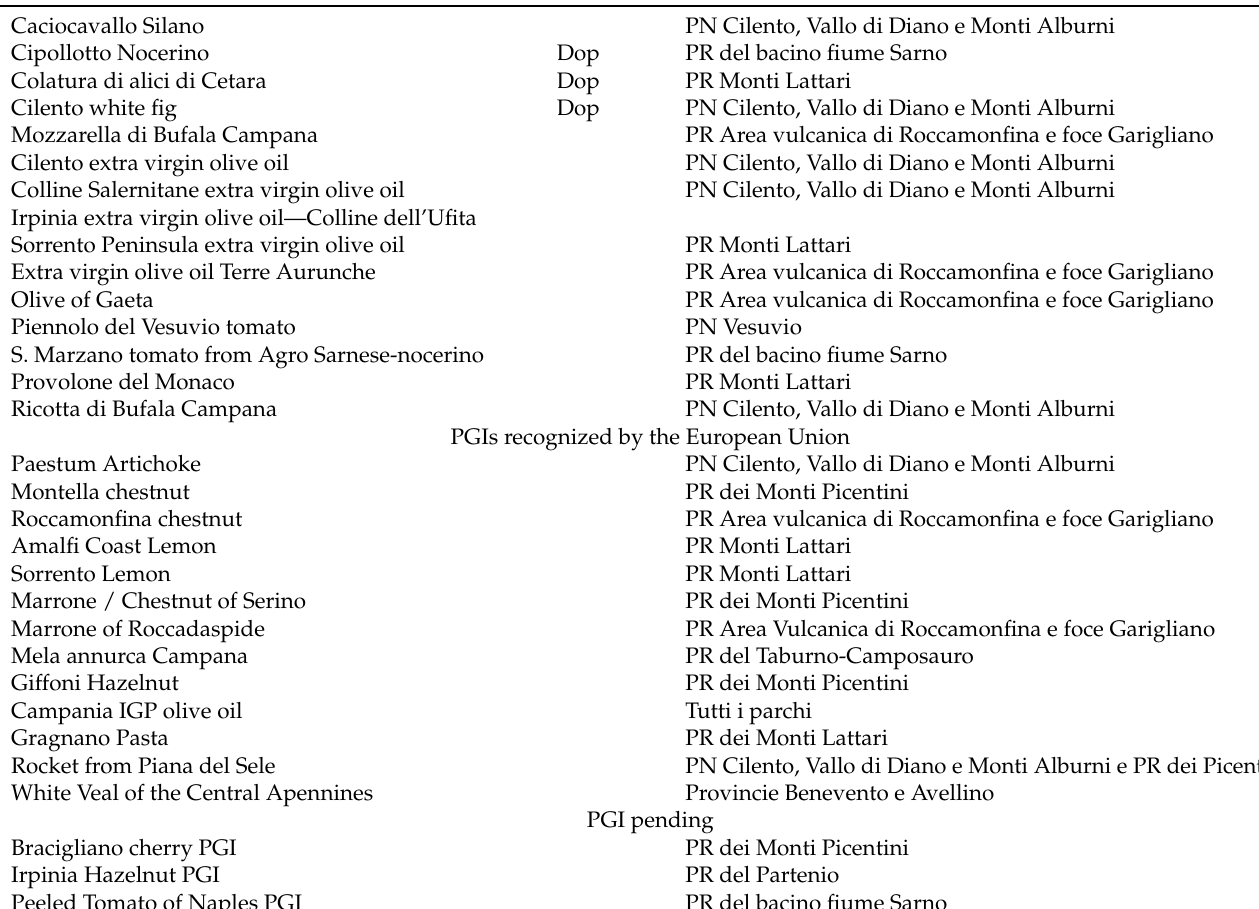
Table 3. Protected designation of origin (PDO), Protected Geographical Indication (PGI) from the Campania Region and parks (elaboration Antonio Bertini). Protected designation of origin (PDO), Protected geographical indication.